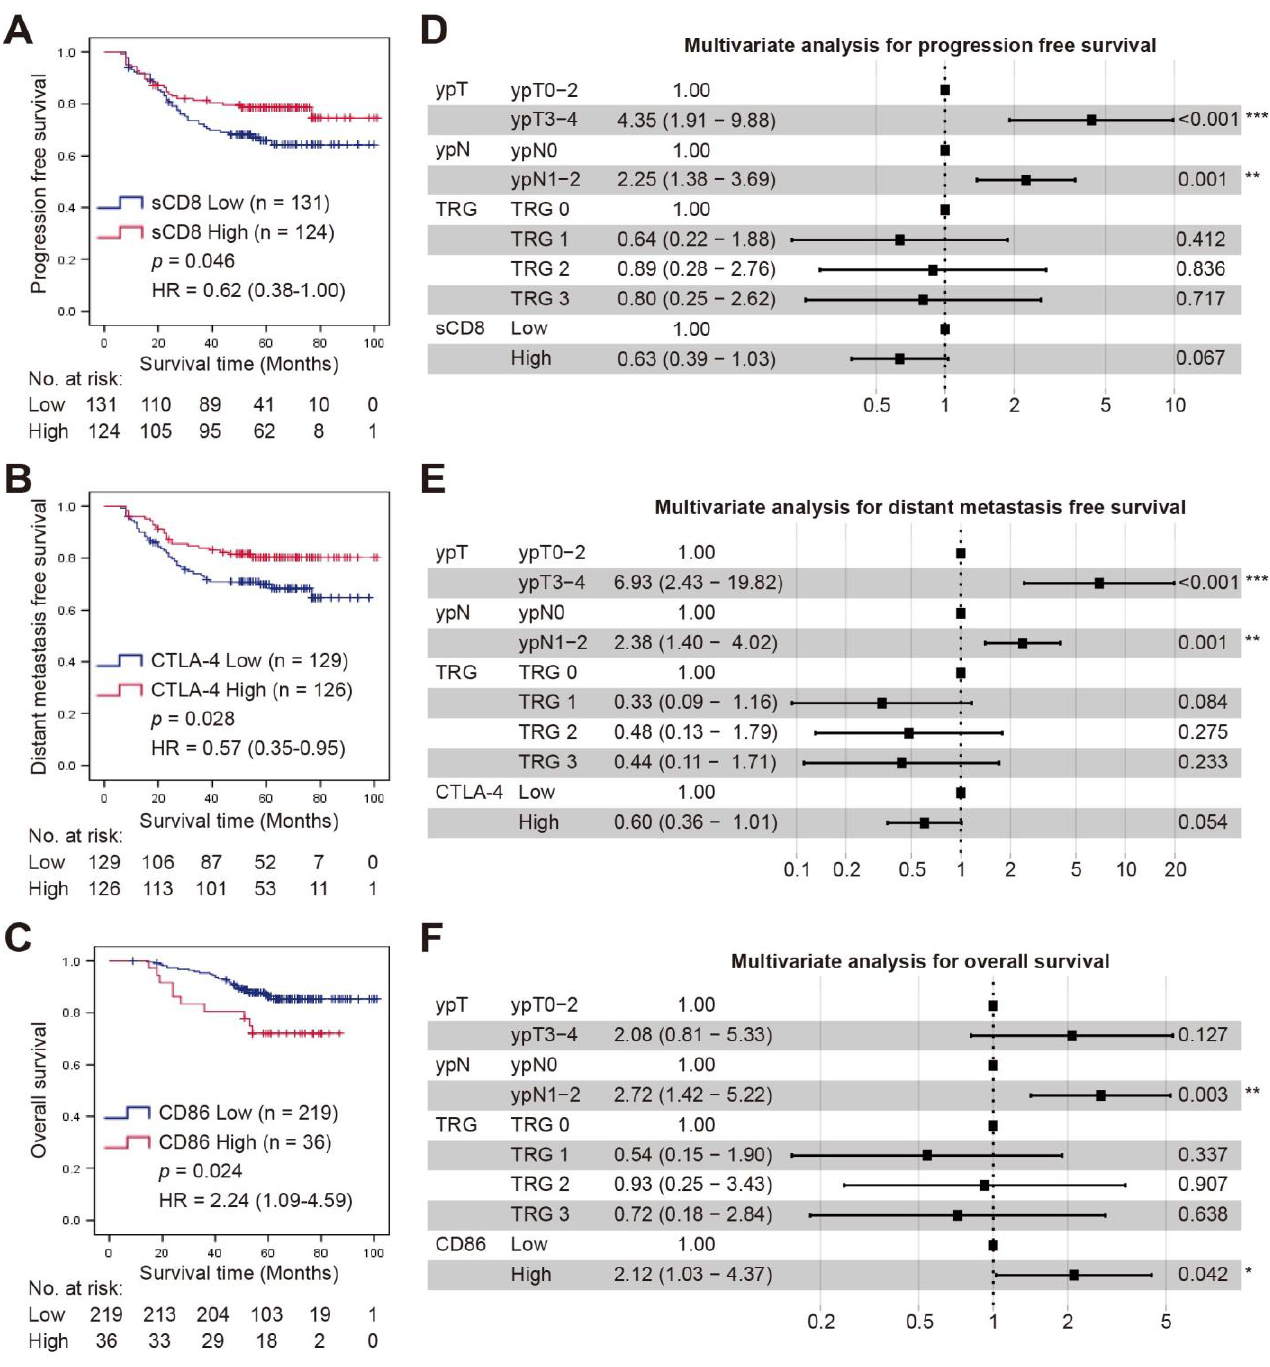
Figure 3. Kaplan-Meier curves and multivariate analysis of survival. ( A ) PFS according to the status of sCD8 + cell (low or high). ( B ) DMFS according to CTLA-4 + cell density (low or high). ( C ) OS according to CD86 expression (low or high) level. PFS, progression-free survival; DMFS, distant metastasis-free survival; OS, overall survival. ( D – F ) Forest plots of PFS ( D ), DMFS ( E ), and OS ( F ) for variables by multivariate Cox analysis. *, p < 0.05; **, p < 0.01; ***, p < 0.001.